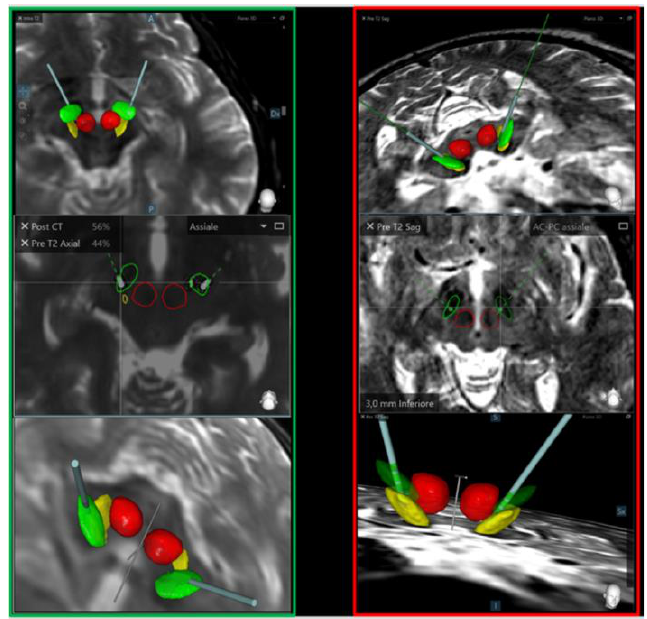
Figure 7. A 3D reconstruction of the lead placement inside the STN in two cases of our series. On the left is an optimal placement in the dorsolateral portion of the STN in a patient (case #13) who showed an improvement of either the motor or the psychiatric performance after the DBS. On the right it is shown the placement of the electrodes in a more medial position (especially the left electrode) in a patient (case #10) who experienced a postoperative mild worsening of the neuropsychiatric performance. Green areas: Subthalamic Nucleus; red areas: red nucleus (nucleus ruber); yellow areas: substantia nigra. The bars in light blue or in green dotted lines indicate the electrodes.